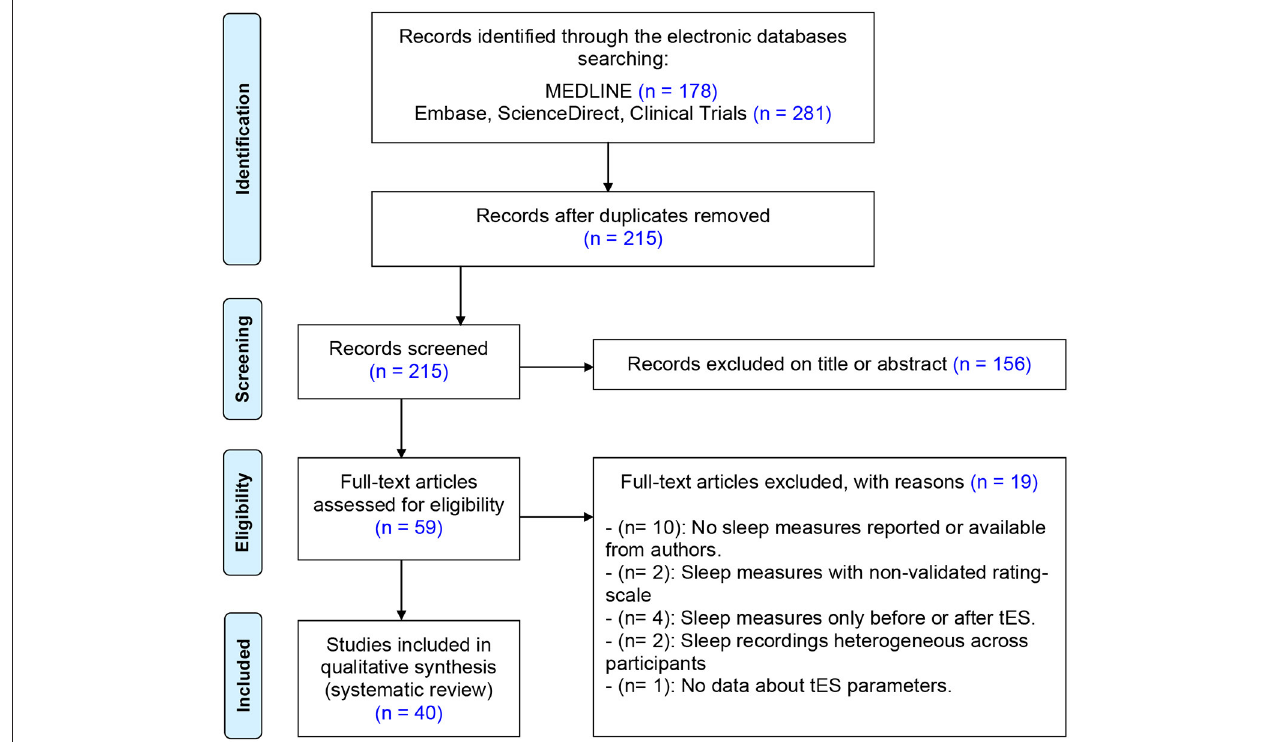
FIGURE 1 | Flow diagram for the systematic